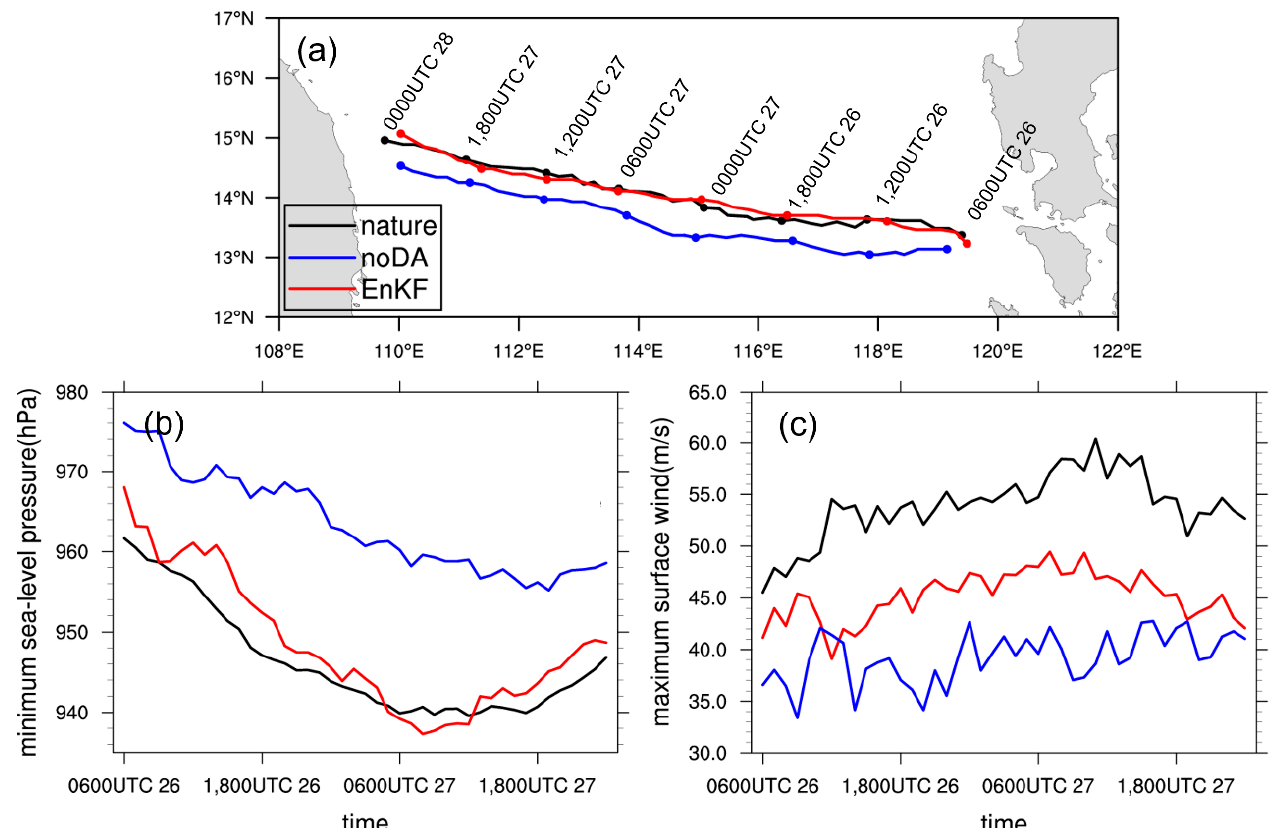
Figure 4. The ( a ) track, ( b ) minimum sea-level pressure, and ( c ) maximum surface wind forecast of TC Molave in EnKF (red curve), noDA (blue curve), and nature run (black curve).